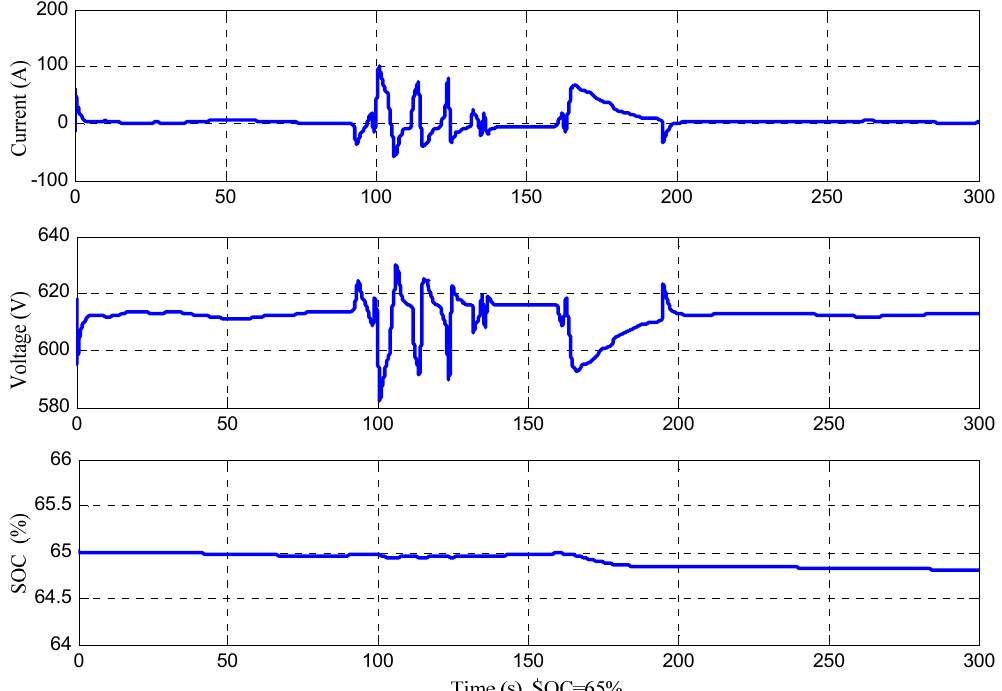
Figure 16. Battery characteristics for Case